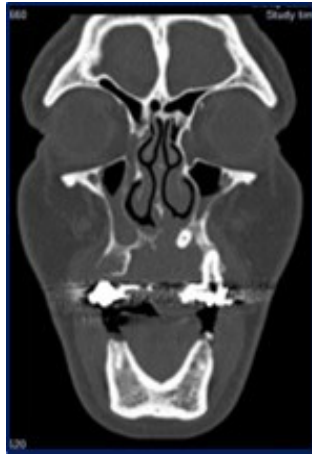
Figure 3. Sagittal computed tomography showing the extension of the lesion, with erosion of the hard palate and involvement of the maxillary sinus up to the orbital base.